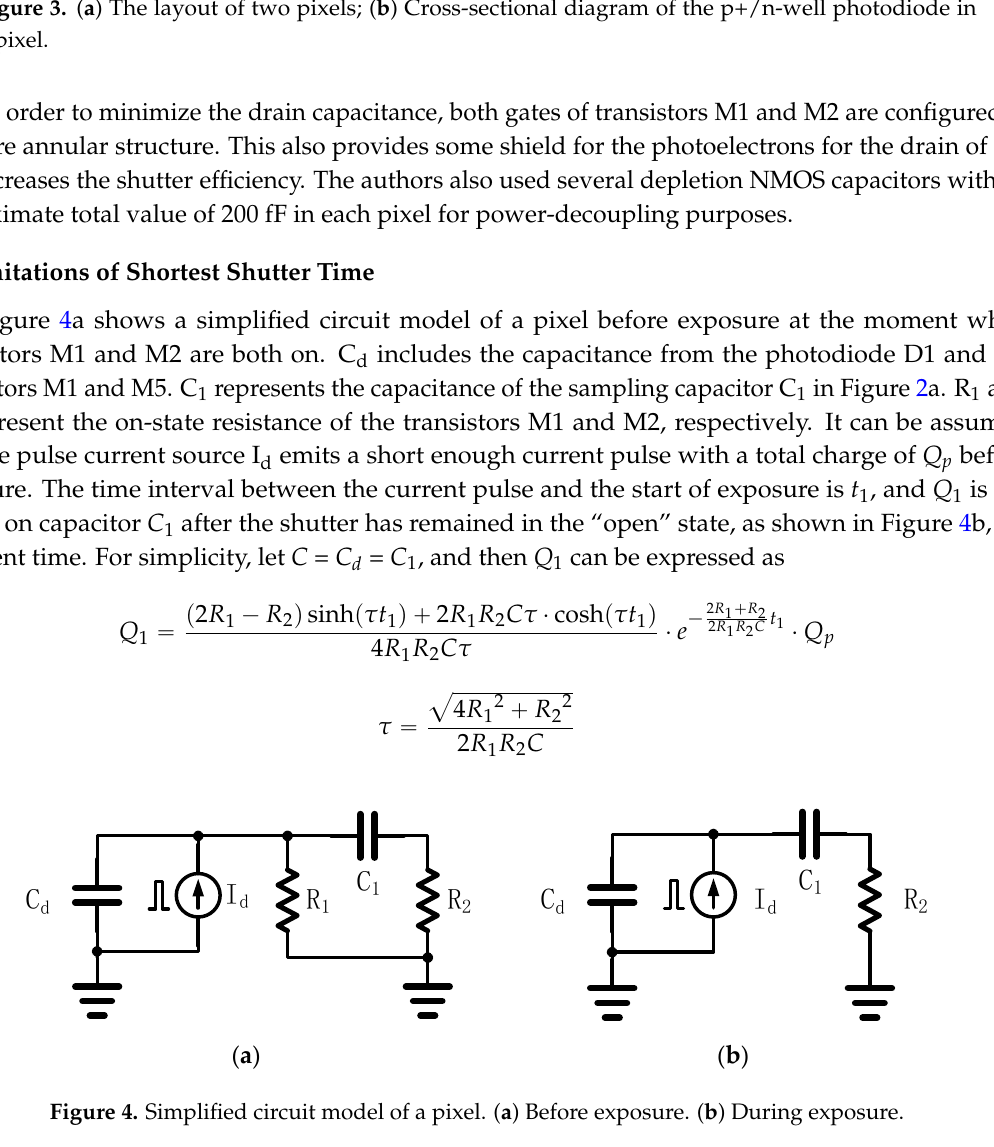
×4 ×4 ( b ) Figure 5. ( a ) Micrograph of the designed image sensor. ( b ) Structural diagram of the designed image sensor; simplified schematic of a single vertical component in the clock trees. The exposure control signals V start and V end are firstly distributed across the horizontal components [4,5], then across the vertical components of the clock trees, and finally to the pixels. The vertical components of the clock trees are placed in the pixel array by pruning one row of pixels after every eight rows, as shown in Figure 5b. The three even and the four odd vertical components of the clock trees belong to the V start and the V end signals, respectively. A simplified schematic of the single vertical components of the clock trees is shown in the right part of Figure 5b. These clock trees consist of fast falling-edge digital buffers [12] and distributed power decoupling capacitors. This type of design of clock trees can be easily extended to large-format gated CMOS image sensors. Since balanced clock trees with fast falling-edge digital buffers are used in the exposure control signal distribution in both the horizontal and vertical directions, and the output of the final nodes of all vertical components of the V start clock tree are connected together as shown in the right part of Figure 5b, as are the horizontal components and the V end clock tree, the exposure signal skew should be relatively small compared with the shortest shutter time of the small designed image sensor. The image signal from the pixels is first multiplexed by an analog multiplexer to a voltage shifter, and it is then buffered by an on-chip analog buffer and eventually drives an off-chip analog-to-digital (A/D) converter.